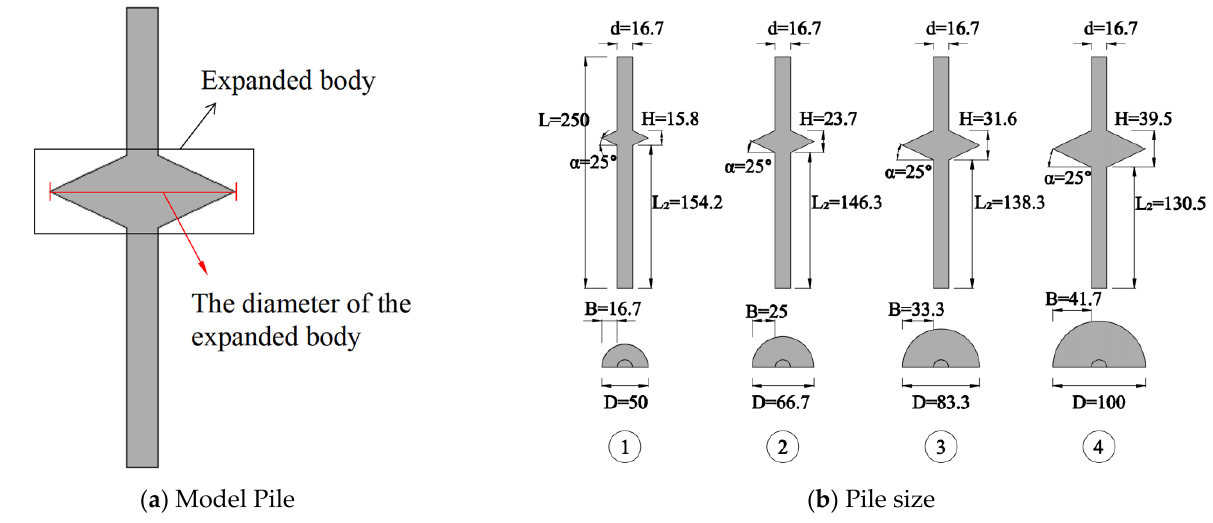
Figure 2. Schematic diagram of the model pile size (Unit: mm).